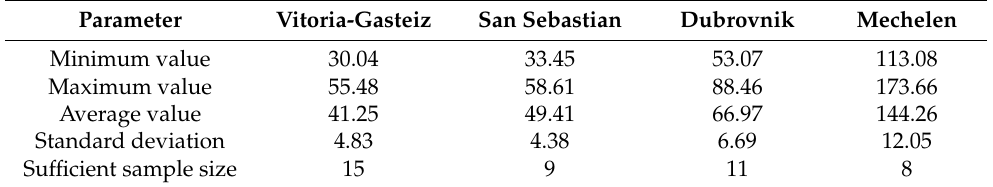
Table 2. Parameters of the total distance covered by traditional vehicles for the basic scenario [km].